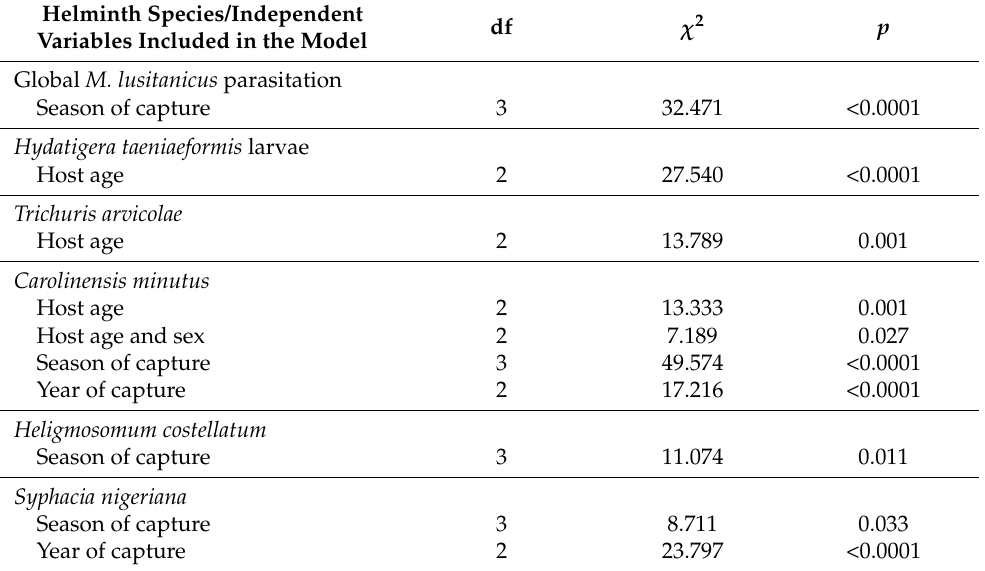
Table 13. Binary logistic regression models for the prevalence of the helminth component species of Microtus lusitanicus from Asturias by year and season of capture, host sex and age, expressed by χ 2 values with associated probabilities ( p ) for the model created, including independent variables. Only statistically significant models are reported.